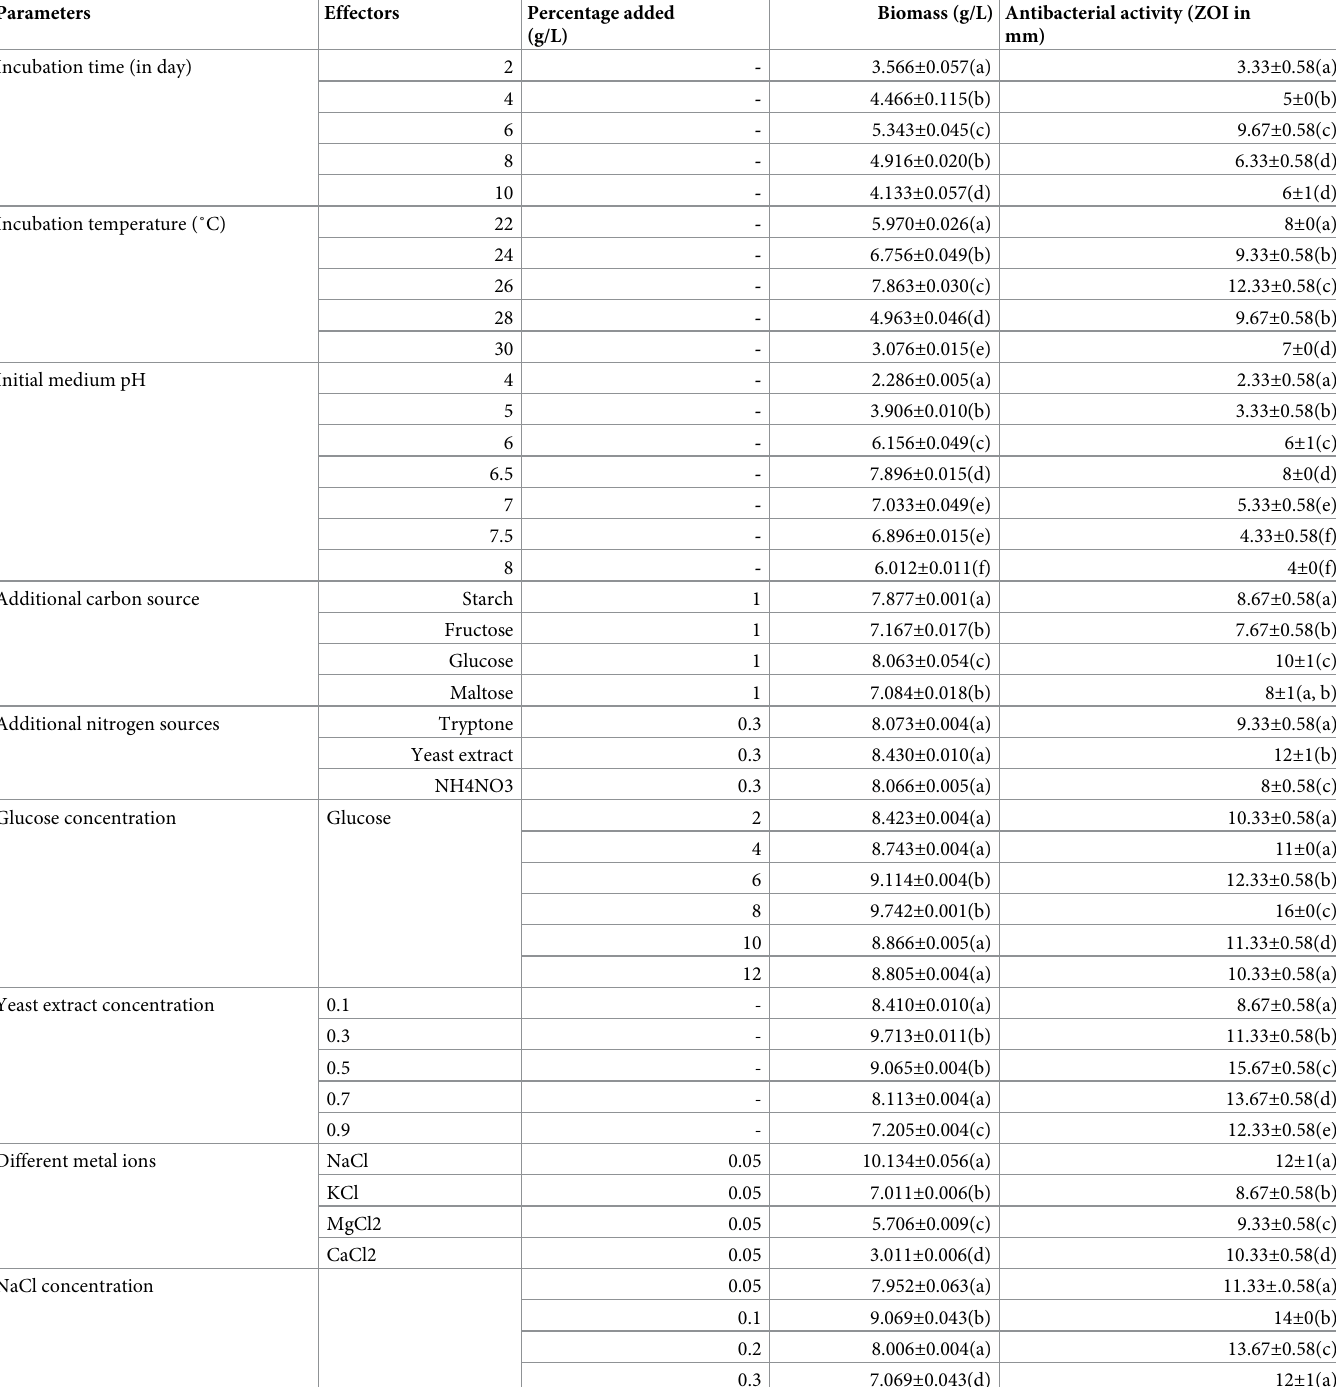
Table 2. Effect of different physical conditions and chemical supplements on biomass and antibacterial activity (ZOI-zone of inhibition) by Colletotrichum alatae LCS1. Against MRSA (Methicillin resistant Staphylococcus aureus